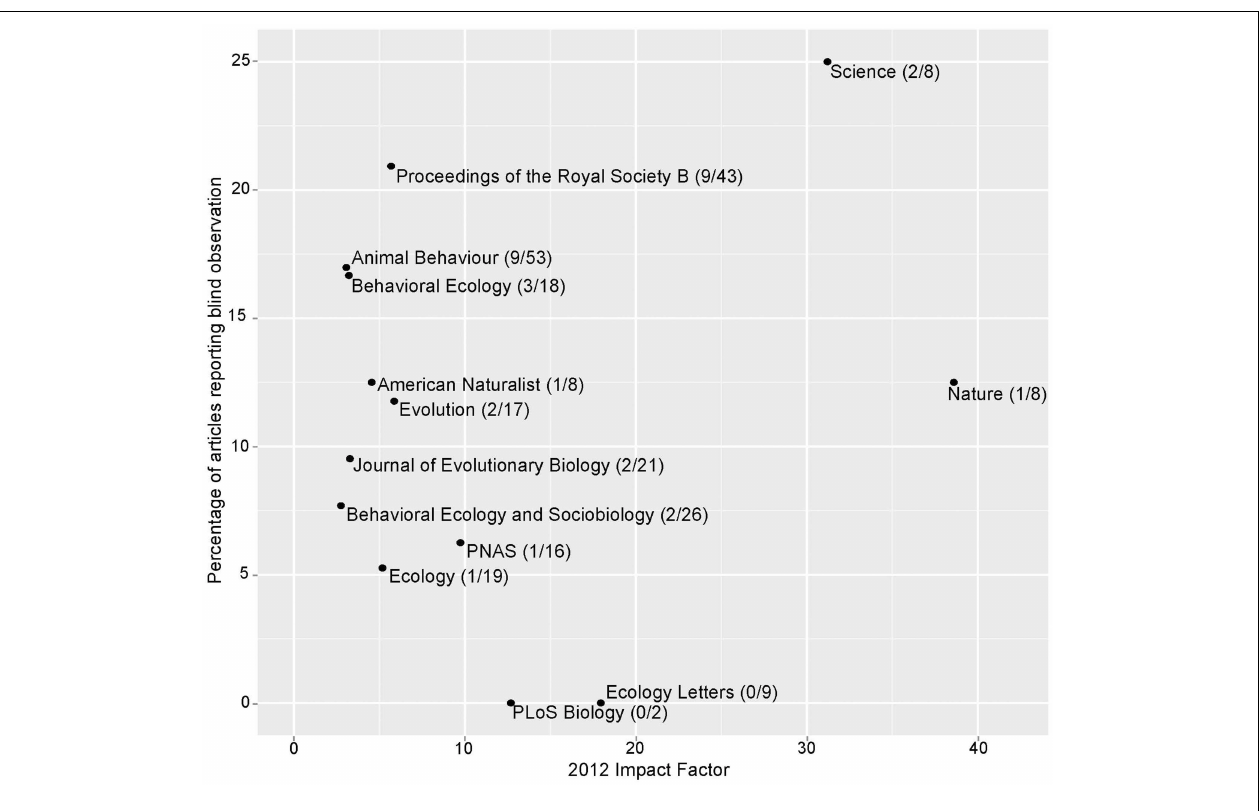
FIGURE 2 | Of the 13 surveyed journals publishing in ecology, evolution, and behavior, the percentages of articles reporting the use of blind observation does not differ between journals ( G -test with Williams correction, df = 12 , p = 0 . 7323 ). Percentage is calculated as the